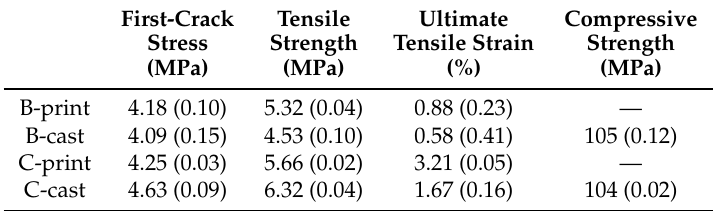
Table 3. Results of the mechanical tests—mean values: coefficients of variation are given in